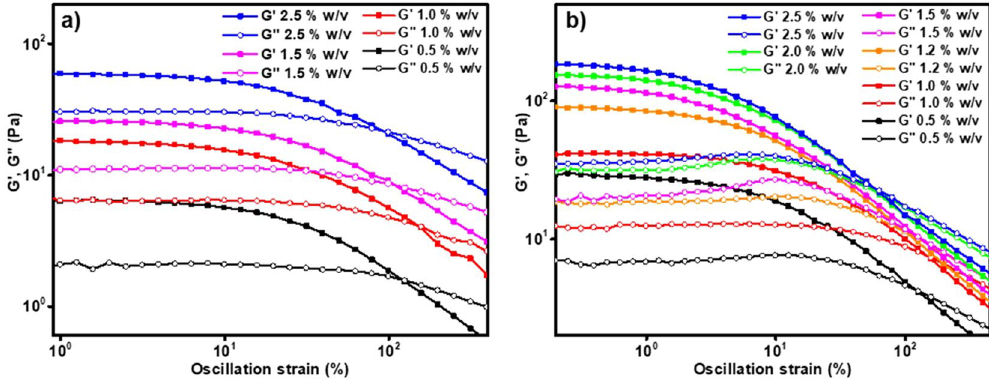
Figure 3. Rheology data on hydrogels of different mucilage-to-water ratios: ( a ) Chia mucilage gels, 0.5% w/v to 2.5% w/v; ( b ) Basil mucilage gel, 0.5% w/v to 2.5%